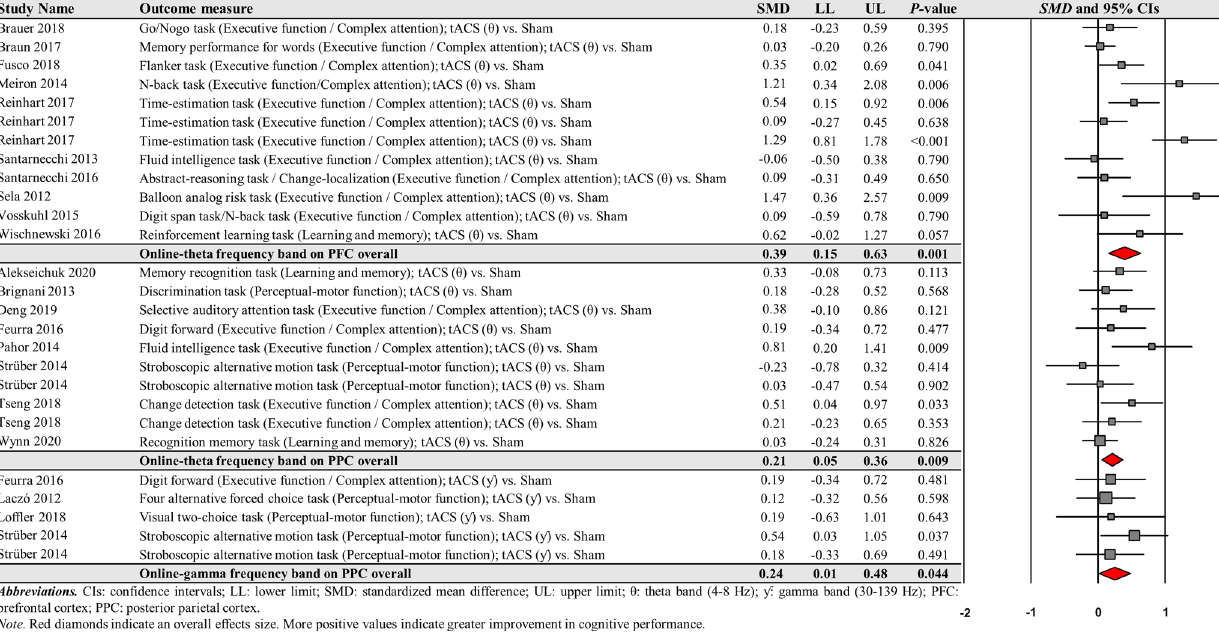
Fig. 7 Cognitive performance comparisons after online-tACS with theta and gamma frequency bands across targeted brain regions. Meta-analytic fi ndings show potential effects of online-tACS protocols with theta frequency band on PFC and PPC and online-tACS protocols with gamma frequency band on